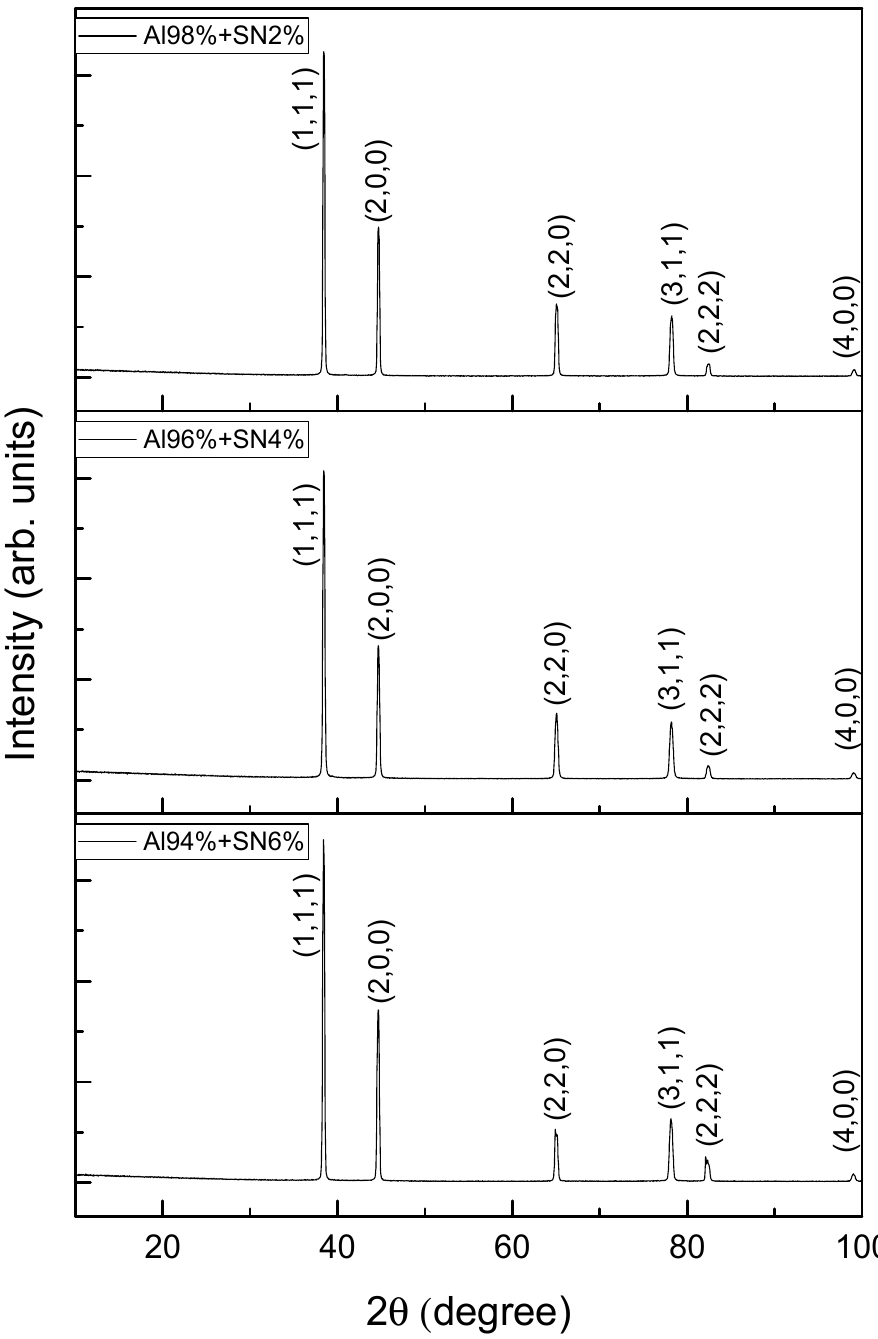
Figure 2. X-ray diffraction of the investigated samples. Table 4. Texture coefficient T(hkl) and crystallite size d ( calculated after (111) plan ).